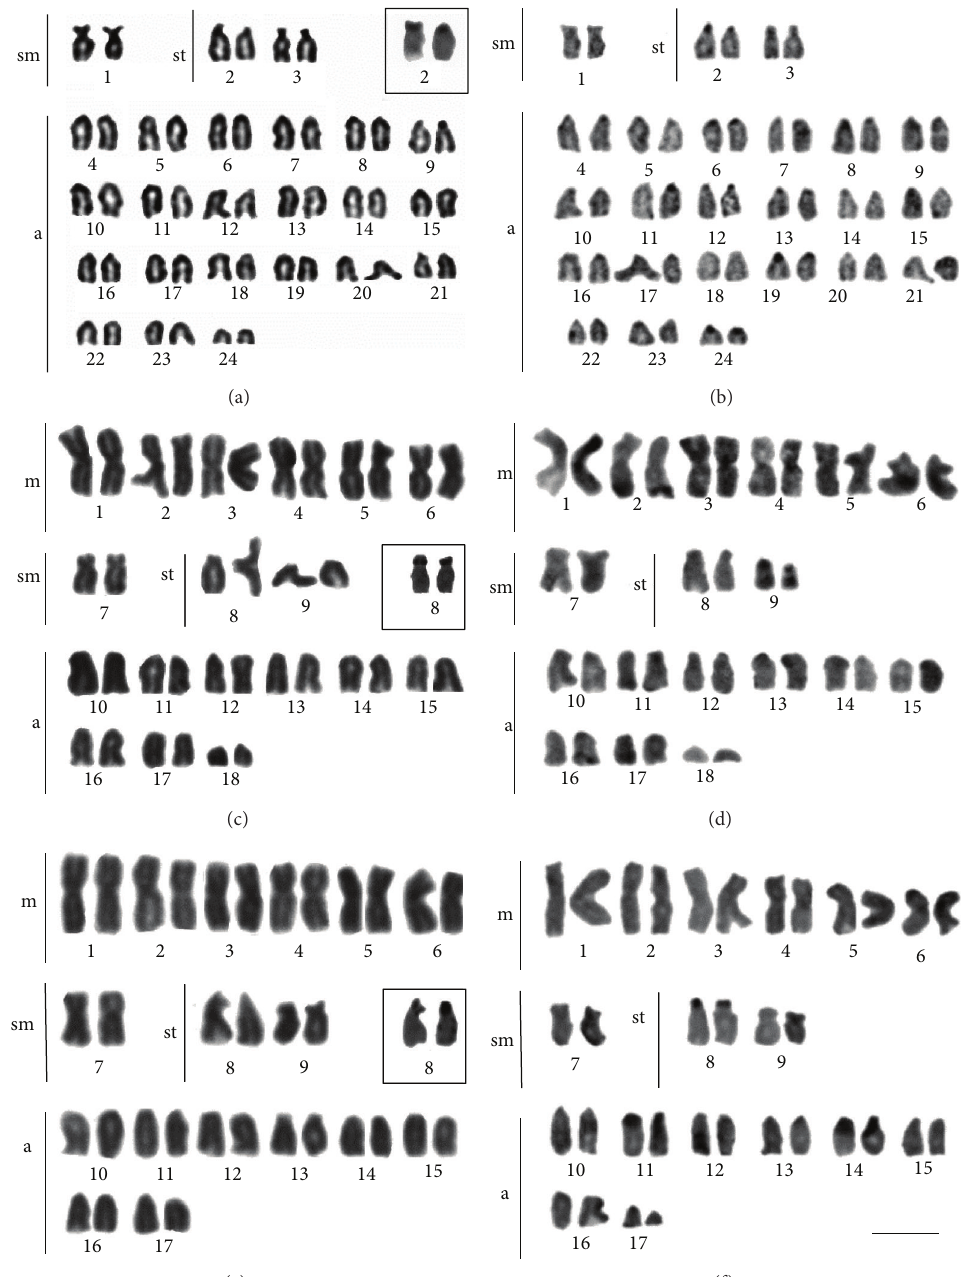
Figure 2: Karyotypes of Acanthurus coeruleus ((a) and (b)) with 2𝑛 = 48 , A. bahianus ((c) and (d)) with 2𝑛 = 36 , and A. chirurgus ((e) and (f)) with 2𝑛 = 34 after conventional Giemsa staining ((a), (c), and (e)) and C-banding ((b), (d), and (f)). The NOR-bearing chromosomes after silver nitrate staining of each species are shown in boxes (pair 2 of A. coeruleus and pair 8 of A. bahianus and A. chirurgus ). number of A. bahianus equals 2𝑛 = 36 with a karyotype com- terminal C-bands were also observed in some pairs posed of 12 large metacentric, two submetacentric, four sub- (Figure telocentric, and 18 acrocentric chromosomes (Figure 2(c)) while A. chirurgus was characterized by 12 large metacentric, two submetacentric, four subtelocentric, and 16 acrocentric chromosomes ( 2𝑛 = 34 ) (Figure 2(e)).